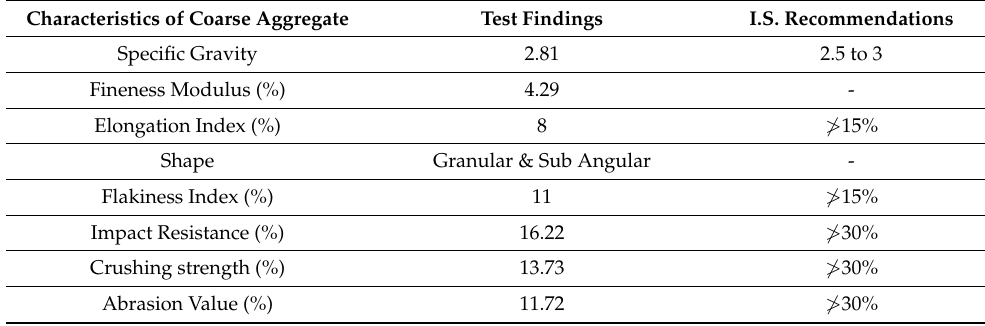
Table 4. Physical Characteristics of Coarse